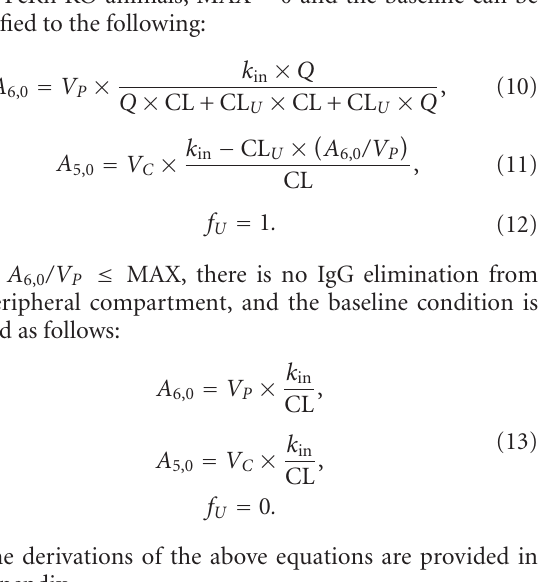
Figure 1: The proposed cuto ff PK models. The full physiological model scheme (upper panel) describes physical processes, including IgG distribution in central, peripheral, and endosome compart- ments, nonspecific elimination from central compartment (CL), and FcRn-mediated endosomal IgG recycling and elimination in the endosome. The endosome space is nested in the peripheral com- partment. In the reduced cuto ff PK model scheme (lower panel), the endosome compartment is collapsed. The net endosomal IgG clearance is determined by endosomal uptake clearance (CL U ) from the peripheral compartment, the FcRn capacity (Max), the total IgG concentration in peripheral compartment ( C P , T ), and the unbound fraction ( f U ), where f U = ( C P , T − Max) /C P , T if C P , T > Max; f U = 0 if C P , T < Max or in FcRn KO